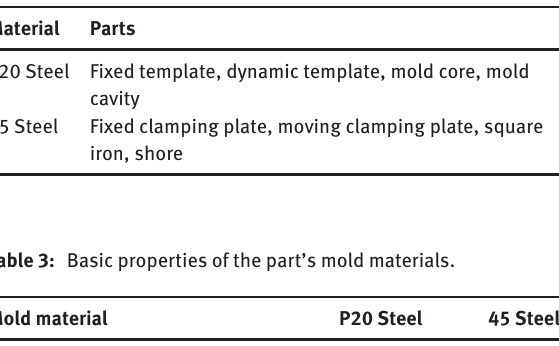
Table 2: Classification of the part’s mold materials.